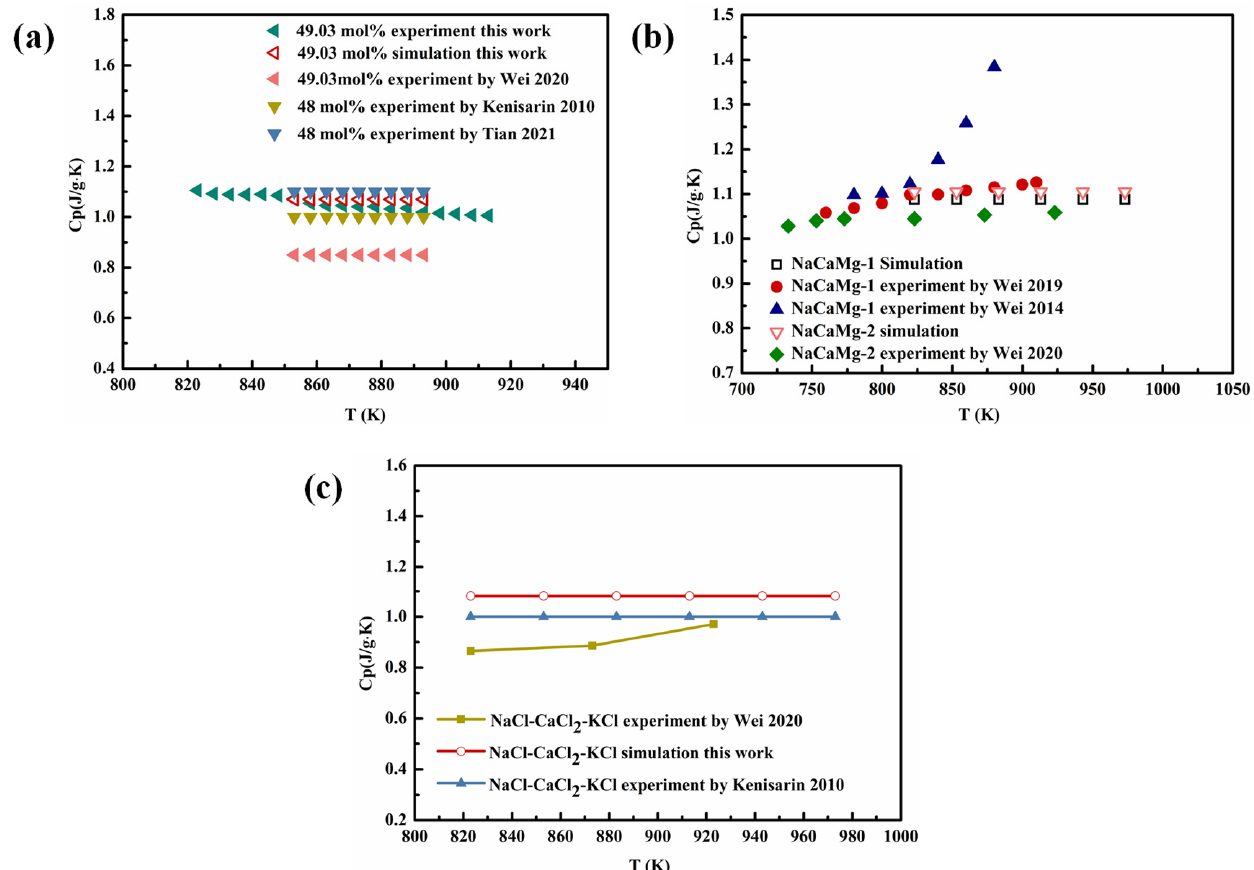
Figure 5. Specific heat capacities of chloride eutectic molten salts of ( a ) binary NaCl ‐ CaCl 2 , ( b ) ternary NaCl ‐ CaCl 2 ‐ MgCl 2 and ( c ) NaCl ‐ CaCl 2 ‐ KCl vs . temperature [4,5,30–32].